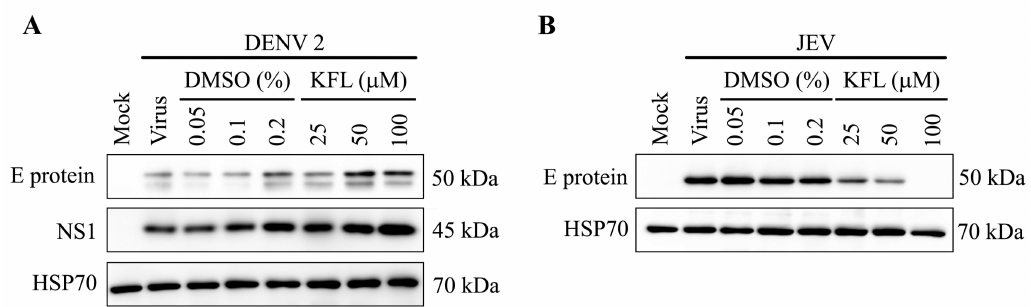
Figure 7. Evaluation of viral protein expression after treatment with kaempferol. BHK-21 cells were mock infected or infected with either DENV 2 at MOI 5 or JEV at MOI 2 followed by 24 h treatment with kaempferol at the indicated concentrations or with corresponding concentrations of DMSO vehicle. The cells were collected at 24 h post treatment and total proteins extracted. Western blot analysis was performed to validate the protein expression of E protein and NS1 in DENV 2 infection ( A ) and JEV E protein in JEV infection ( B ). Hsp70 was used as an internal protein loading control. Experiments were undertaken independently in